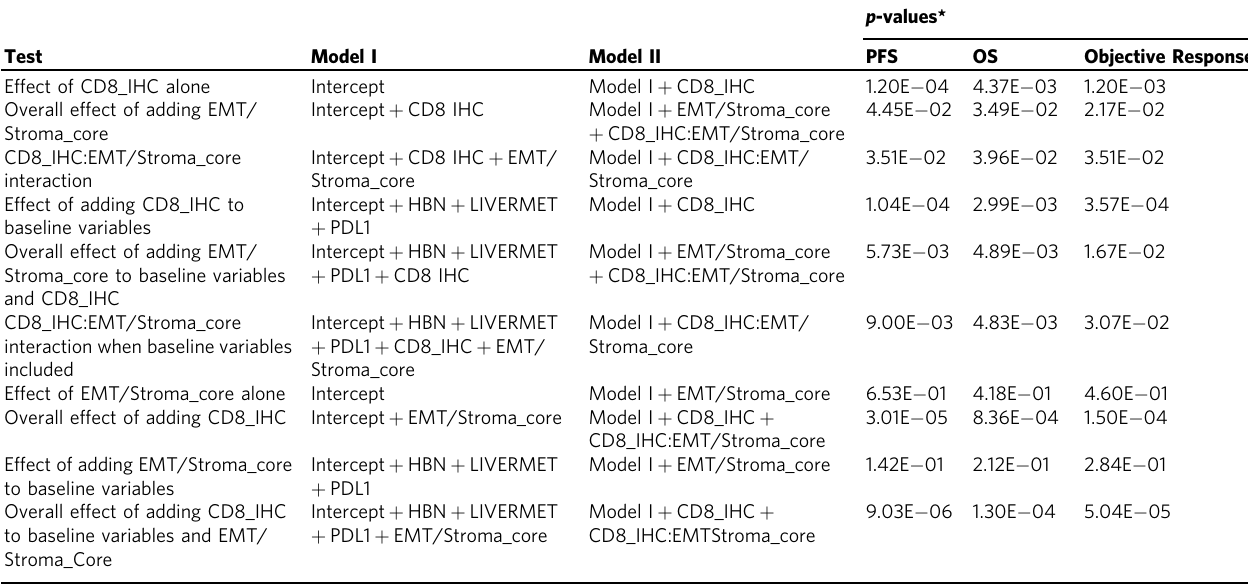
Table 1 Impact of CD8 expression and EMT/Stroma_core gene expression on clinical outcomes in CheckMate 275 biomarker cohort ( n = 214): p